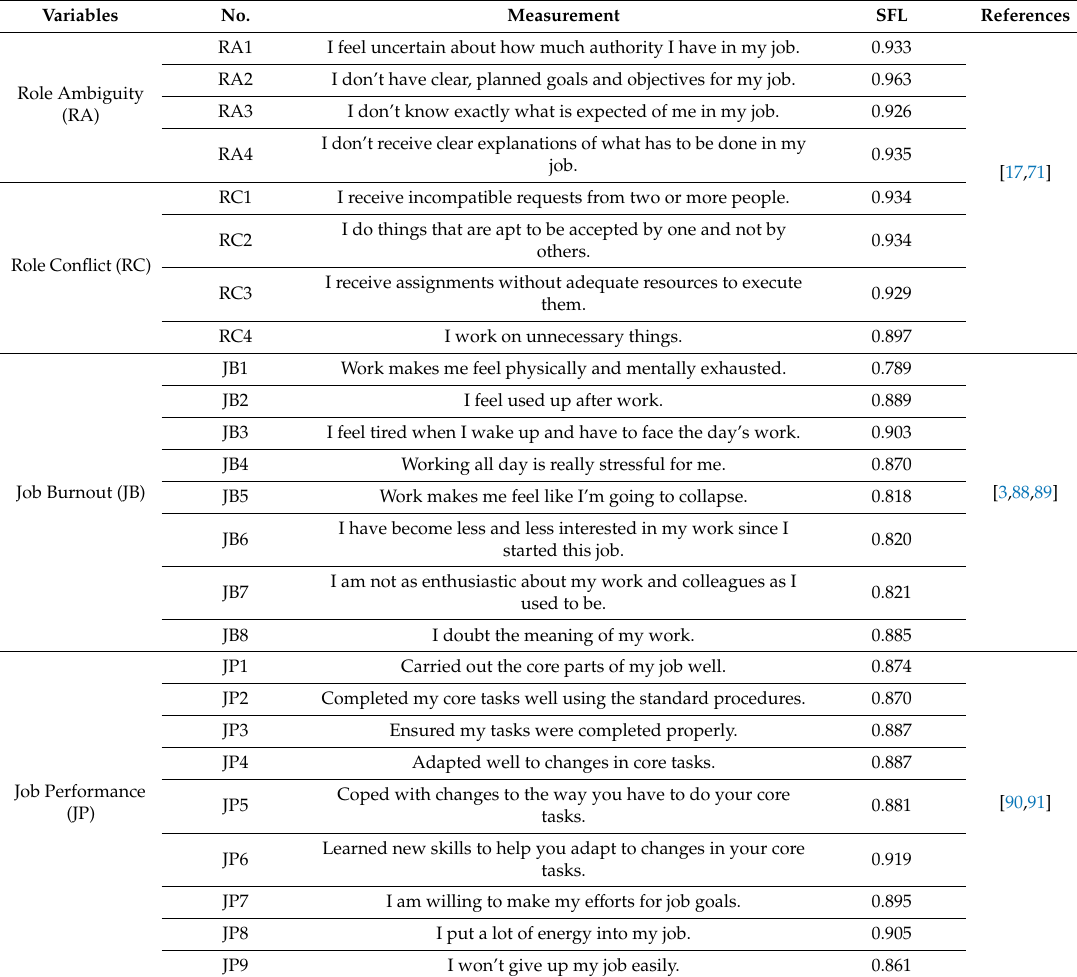
Table 1. Measurements for